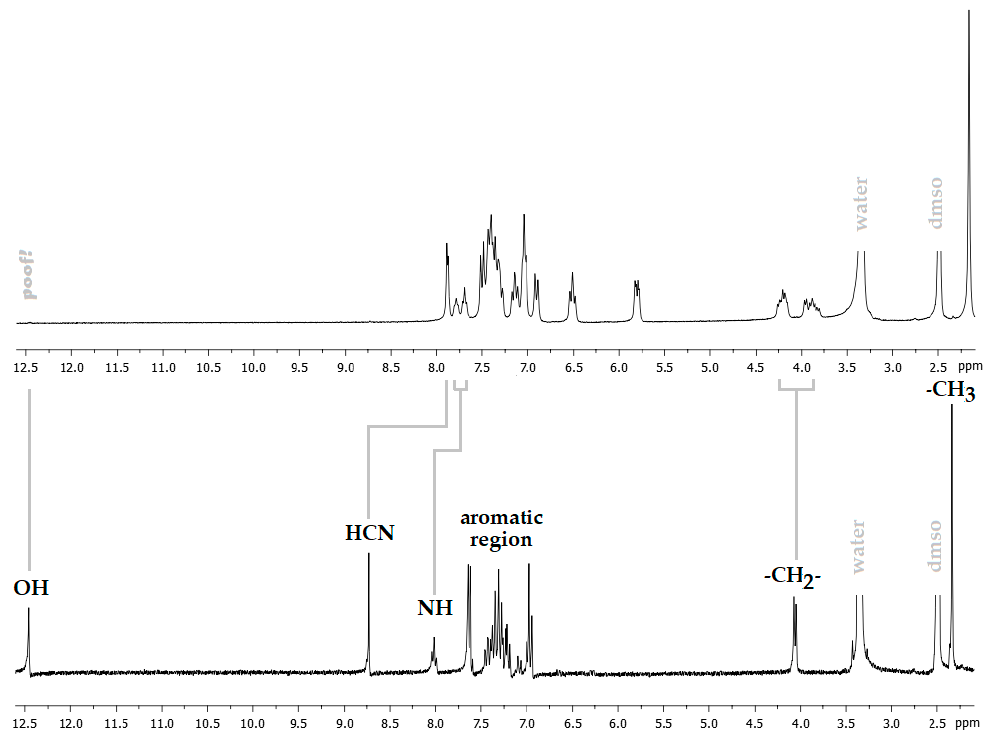
Figure 3. View of the 1 H NMR spectra of Pd(HSB) 2 (top) and H 2 BS (bottom).